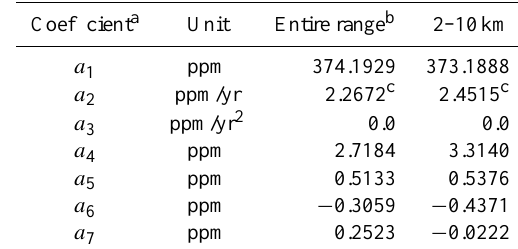
Table 3. Coefficients obtained for least-squares fits with Eq. (4) to X CO over Tsukuba during the period January 2007–May 2